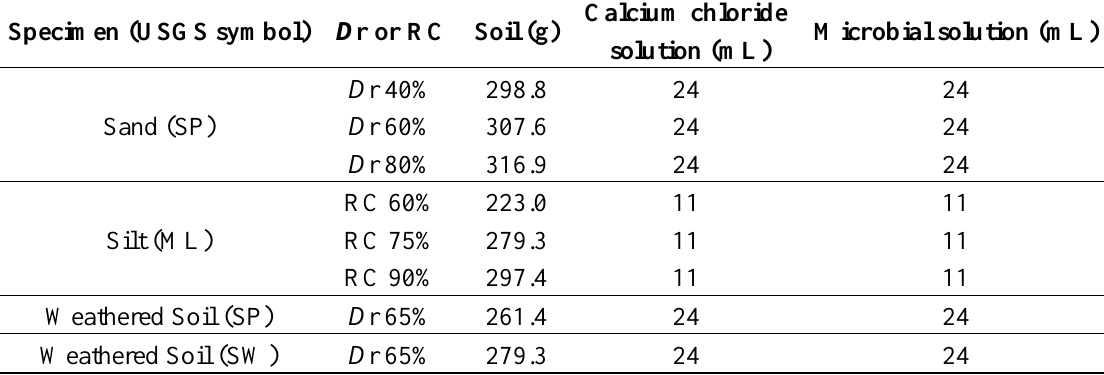
Table 2. Specimen mixing ratios of sand, silt and weathered soil specimens. D r, relative density; RC, relative